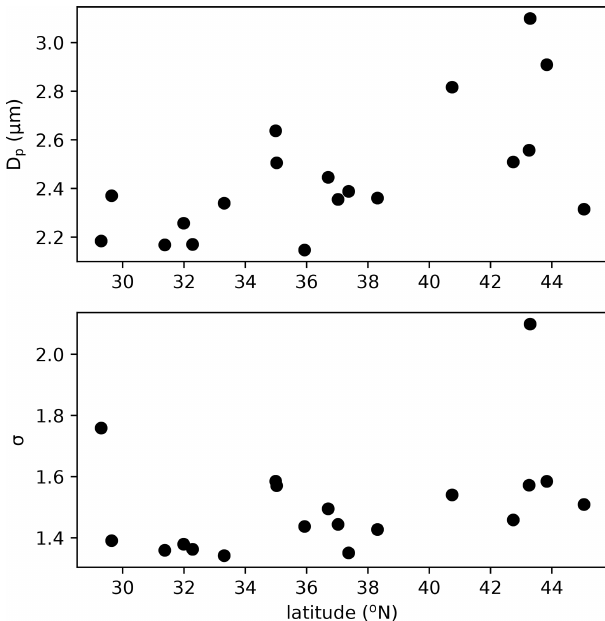
Figure 5. Geometric mean diameter ( D p ) and geometric standard deviation ( σ ) as a function of latitude for the number distribution of FBAP particles observed by WIBS over the continental USA in